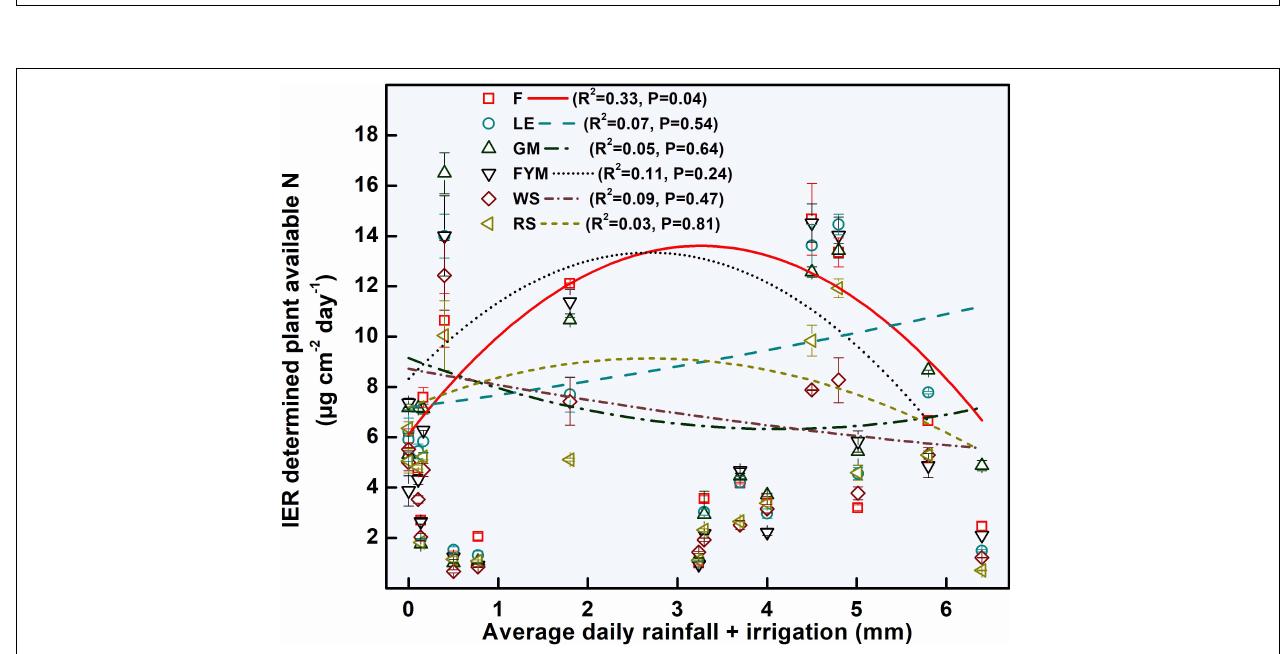
FIGURE 5 | Relation between daily water availability (rainfall + irrigation) and IER (ion exchange resin) determined plant-available nitrogen (N) during the wheat growing season. Error bars denote ± 1SD. Treatments are described in Figure 2 legend.